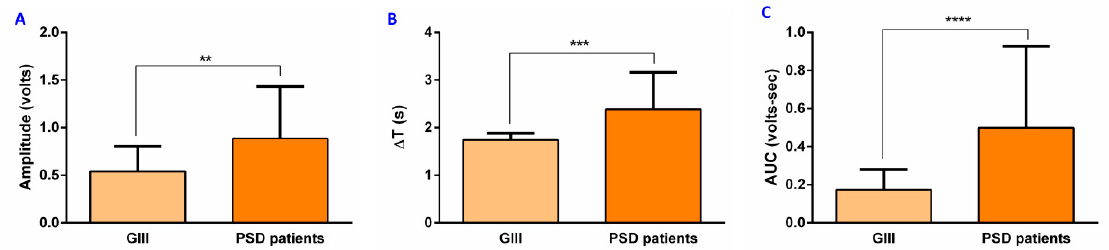
Figure 5. EMG metrics in PSD patients and GIII group: ( A ) amplitude, ( B ) Delta T, and ( C ) AUC. ∆ T: Delta T; AUC: area under the curve; s: seconds; GIII: ≥ 60 years group; PSD: post-stroke dysphagia; ** p < 0.01; *** p < 0.001; **** p < 0.0001.